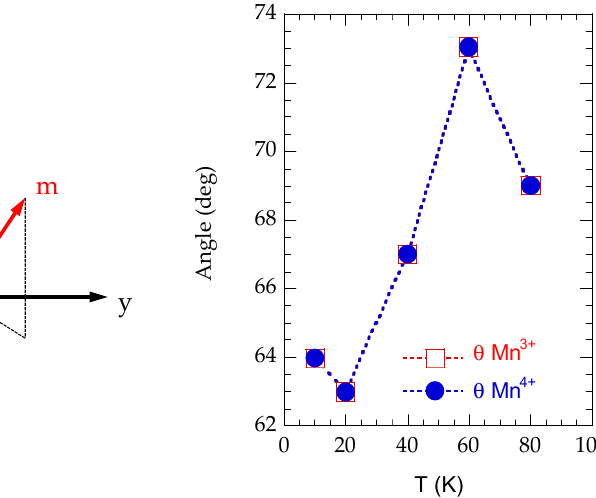
Figure 9. Low-angle scattering range of the neutron diffraction patterns of the Ho 0.5 Ca 0.5 MnO 3 nanoparticles taken at selected temperatures.